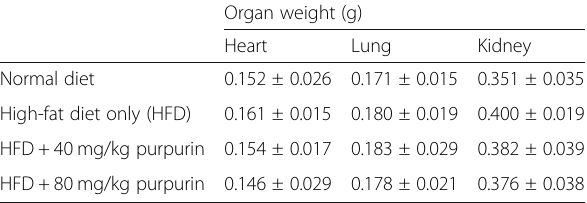
Table 3 Effect of purpurin on organ